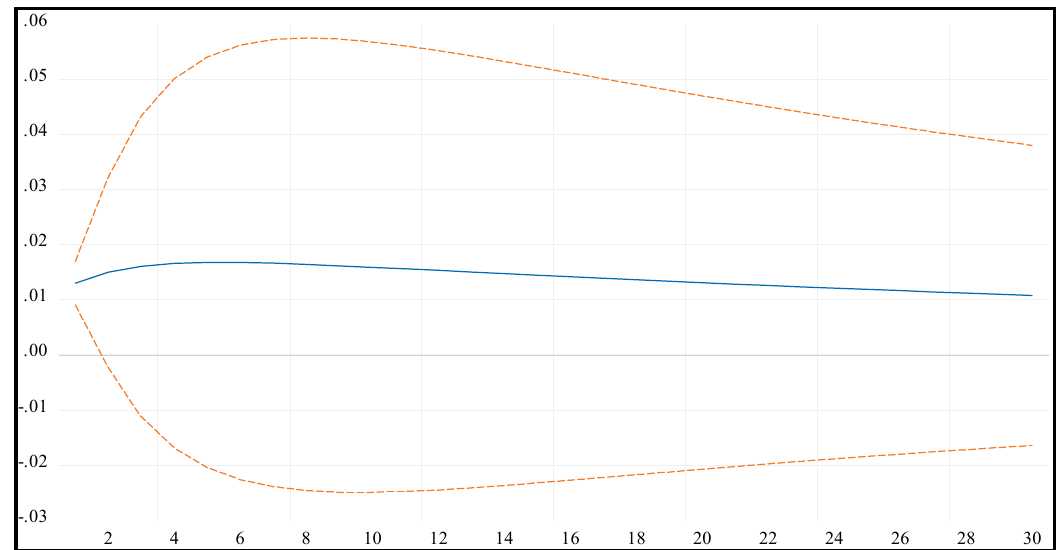
Figure 8. Response of LCO 2 to LGDP using structural VAR factor.